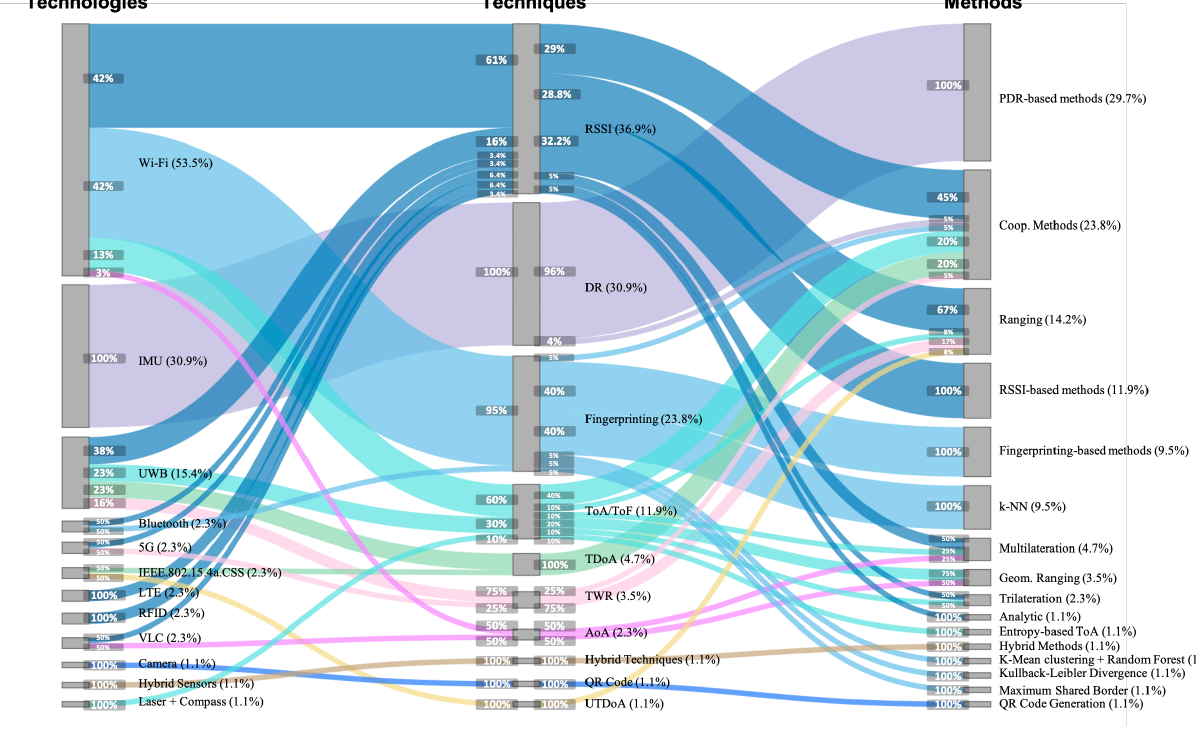
5G (2.3%), IEEE.802.15.4a.CSS (2.3%), Long-Term Evolution (LTE) (2.3%), Radio-Frequency Identification (RFID) (2.3%), Visible Light Communication (VLC) (2.3%), Camera